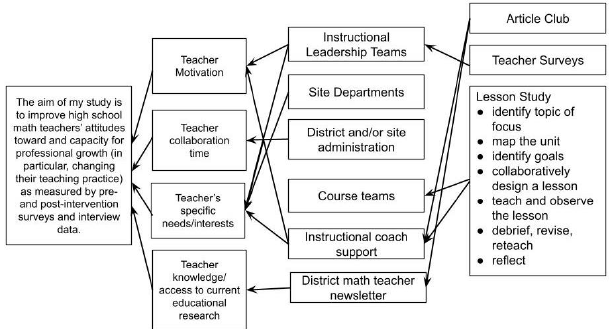
Figure D3. Kerry’s End-of-course Driver Diagram